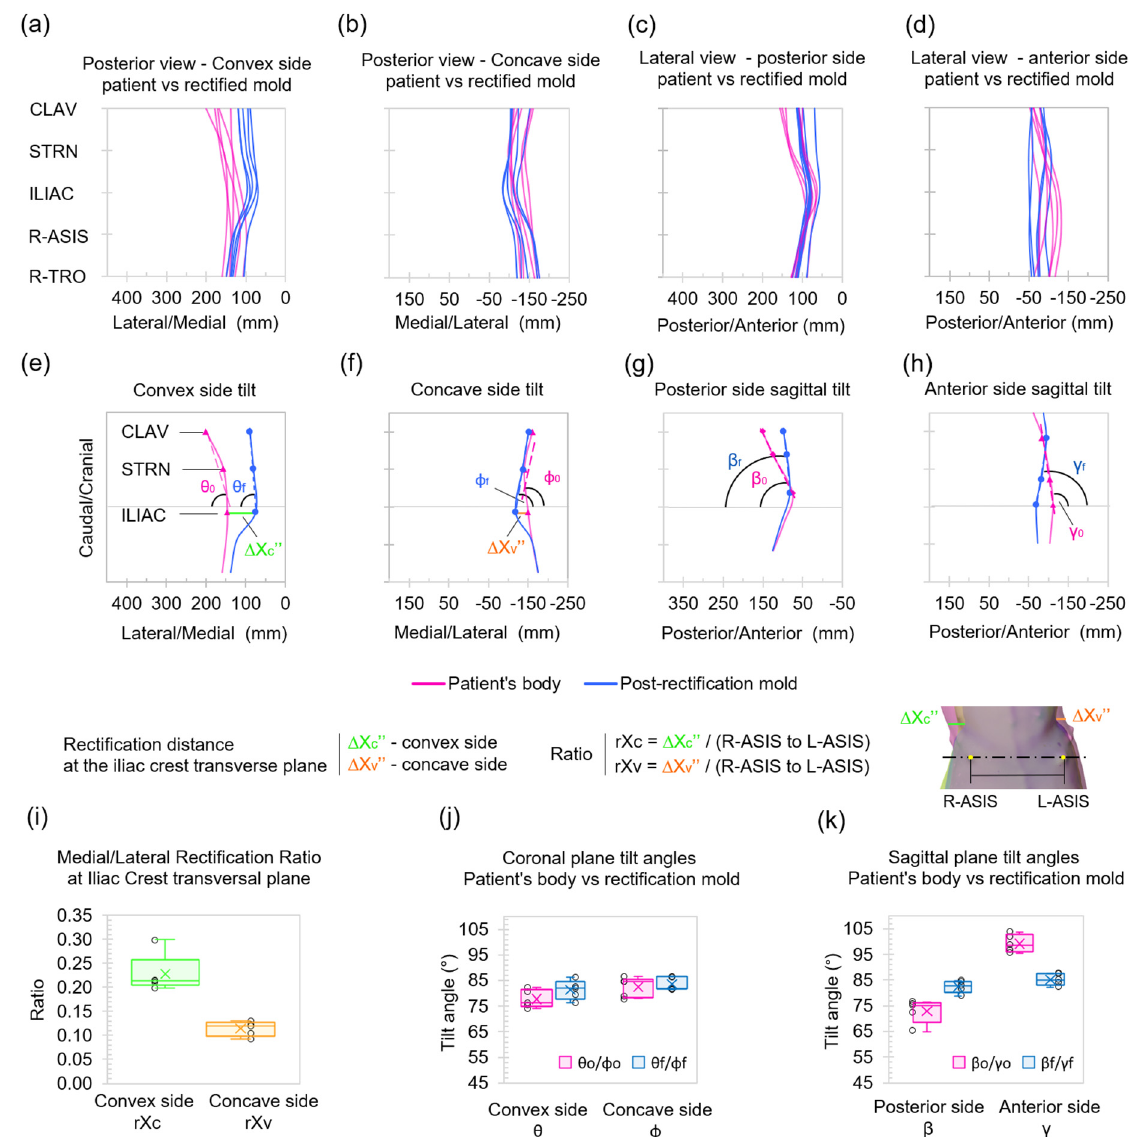
Figure 8i, found from the convex and concave side contours (Figure 8e,f). Furthermore, lateral and sagittal tilt angles on the convex and concave side ( θ and φ , respectively) and posterior and anterior contours ( β and γ , respectively) are shown in Figure 8g,h. Changes in cated at the torso level and R-ASIS and R-TRO at the pelvis level.